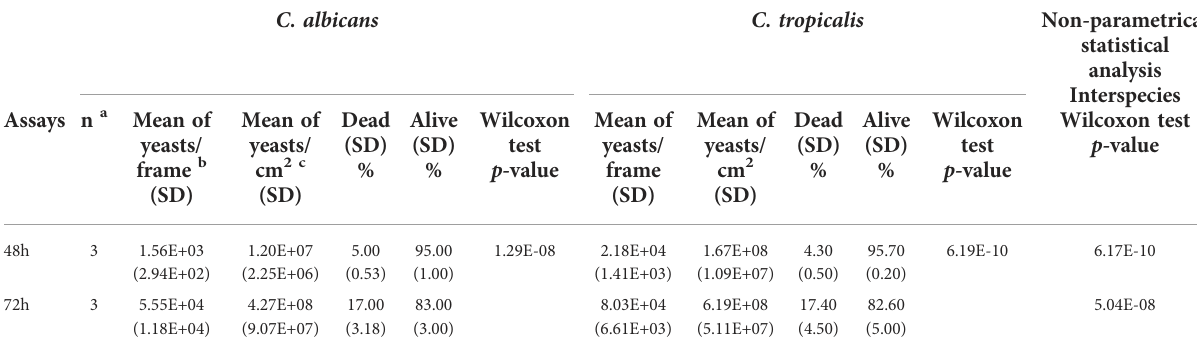
Epi fl uorescence microscopy (EM) with DAPI Staining and LIVE/DEAD Bio fi lm Viability